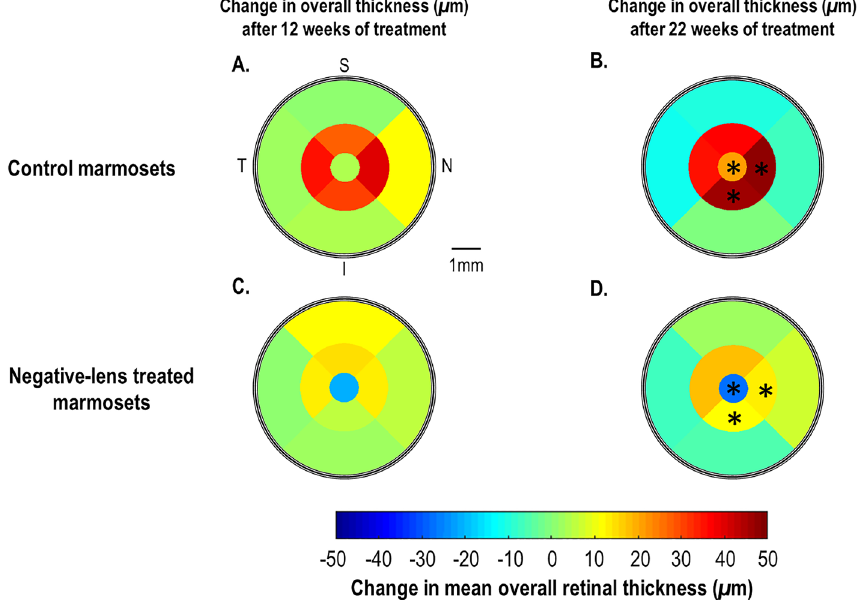
Figure 6. ETDRS color map summarizing the average 12-week change ( A & C ) and 22-week change in overall retinal thickness ( B & D ) for ( A & B ) control marmosets ( n = 5) and ( C & D ) negative-lens treated marmosets ( n = 8). Positive and negative values on color bar represent retinal thickening and thinning relative to baseline, respectively. S = Superior; T = Temporal; N = Nasal; and I = Inferior. Statistically significant difference in retinal thickness between control and negative-lens treated marmosets at the center, nasal inner and inferior inner ETDRS region is indicated by * p < 0.05 (in B & D ).